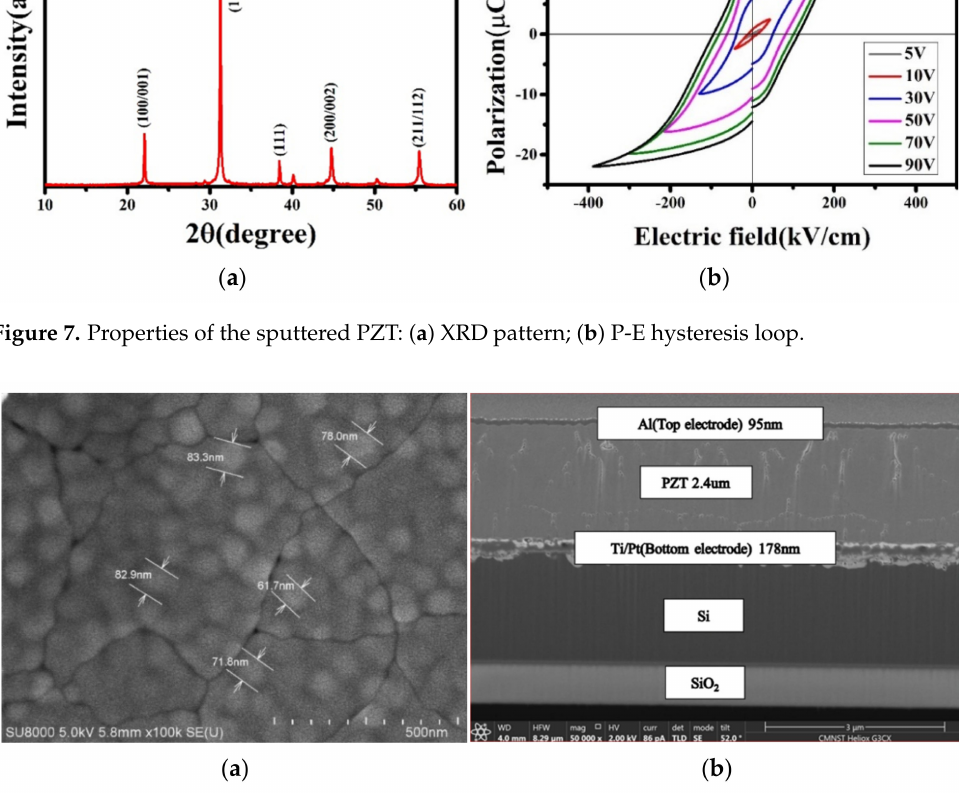
Figure 8. SEM image: ( a ) surface of the PZT; ( b ) cross-section of the